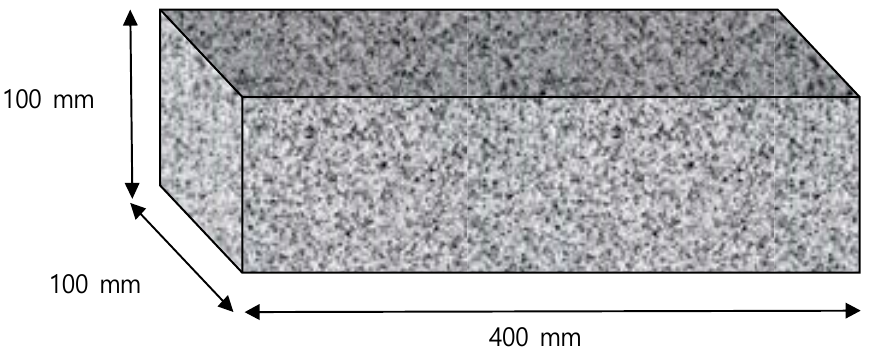
Figure 4. Specimen for accelerated carbonation test .